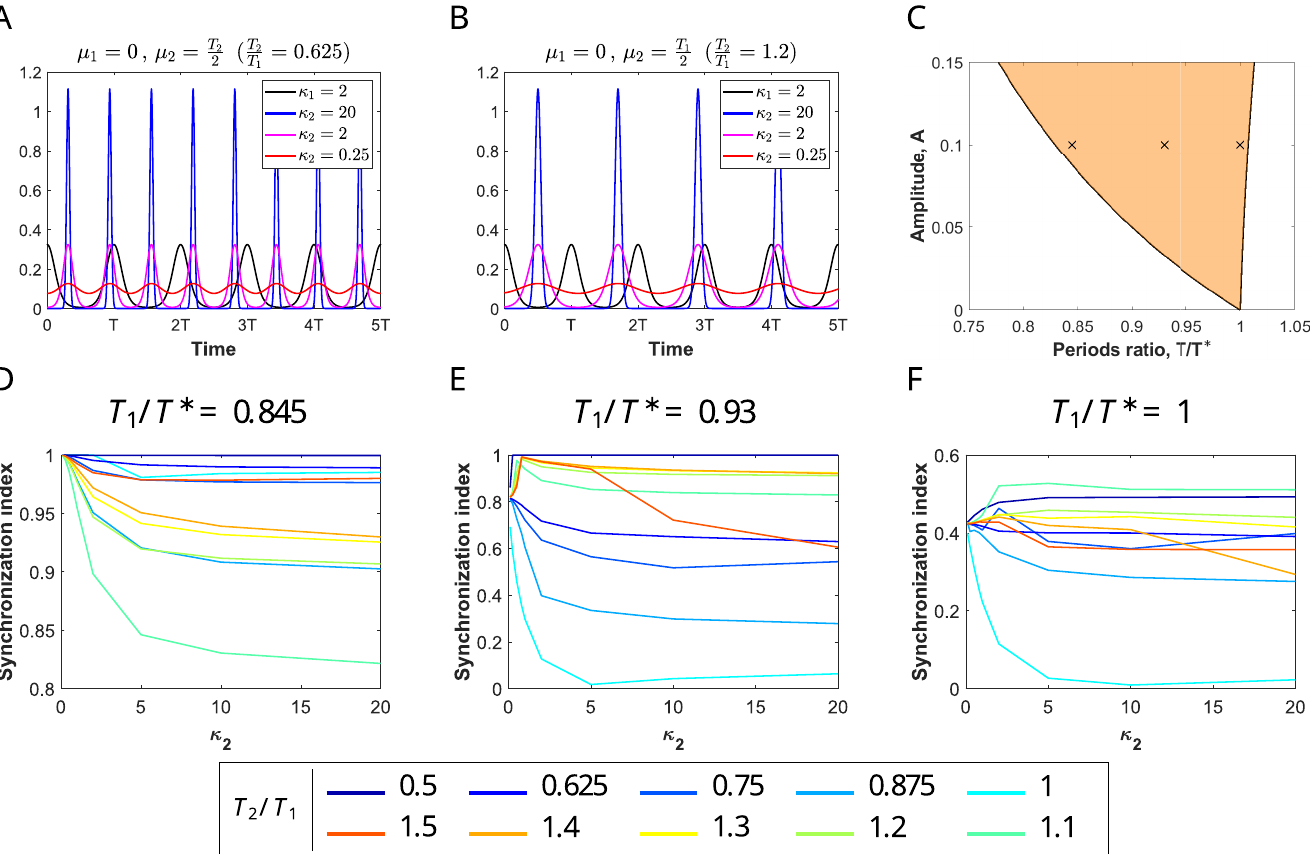
Fig 6. Effect of a non-identical distractor in the network entrained by the primary stimulus. (A, B) Two von Mises inputs of different frequency phase-shifted according to the rule described in Methods. The black curve corresponds to the primary stimulus located about μ 1 = 0 with κ 1 = 2 and period T 1 = T . The other curves correspond to a distractor with different coherence values κ 2 indicated in the legend. The distractor is phase-shifted (A) T 2 /2 if T 2 / T 1 < 1 or (B) T 1 /2, otherwise. (C) Arnold tongue corresponding to 1:1 phase-locking between a single von Mises input with coherence κ 1 = 2 (primary input) and the target network. We have selected 3 orbits along the section A 1 = A = 0.1 (black crosses) corresponding to T 1 / T � = 0.845, 0.93 and 1 (left to right), for which we apply a distractor input of the same strength A 2 = A = 0.1. (D, E, F) Synchronization index r for the stroboscopic map at time T 1 as a function of the coherence of the distractor κ 2 ( x -axis) for different values of the periods ratio between inputs, T 2 / T 1 (color legend). The distractor frequency can be higher (cold colors) or lower (warm colors) than the primary frequency, being as much twice as fast (dark blue line) or 3/2 times slower (red line).